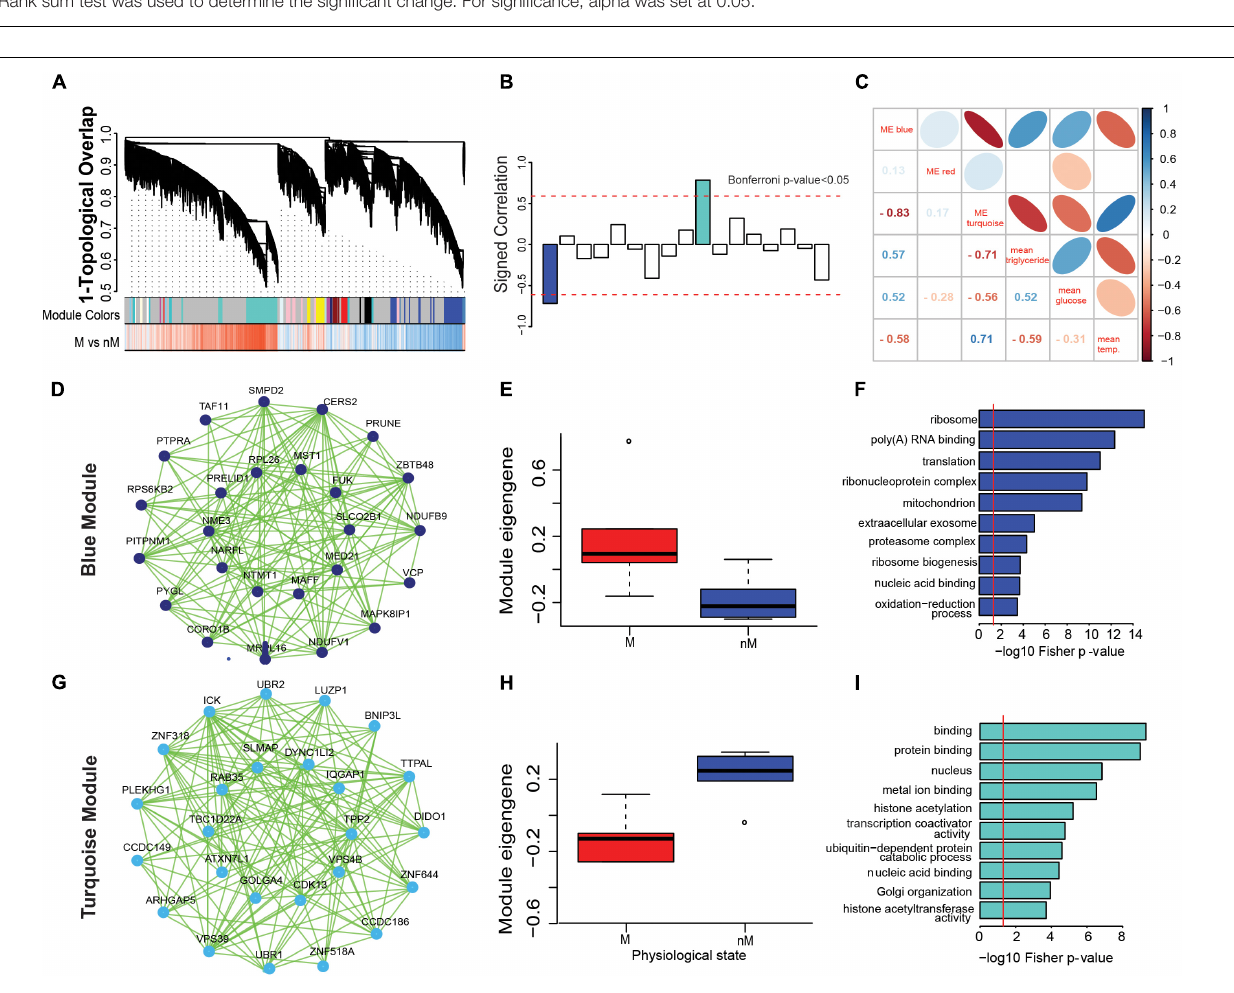
FIGURE 3 | Gene coexpression networks associated with different physiological states. (A–H) : Weighted gene coexpression network analysis (WGCNA) to show modular hub genes and pathways. (A) the hierarchical clustering of genes based on 1-topological overlap (1-TO) distance plotted with signed coexpressed modules. (B) signed correlation of module eigengenes (first principal component of the module) with physiological states, with reference to increased (+ve values) and decreased (-ve values) coexpression patterns in the refractory non-migratory (nM) state. Horizontal dotted red lines indicate threshold significance, as determined by Bonferroni correction. (C) pearson’s correlation of module eigengenes with physiological measures (blood glucose and triglycerides levels and surface body temperature). (D,G) show the coexpression network of first 25 hub genes that were upregulated in M (migratory: blue module, D ) and nM (turquoise module, G ) states. In the inner circle of each module lie genes that showed highest correlation with a module eigengene value. (E,H) show boxplots of relative module eigengene expression between M and nM states in blue (E) and turquoise (H) modules, with significance determined by Wilcox Rank sum test (the outlier values are shown by a dot). (F,I) are the gene ontology term enrichment of blue and turquoise modules, respectively. For significance, alpha was set at